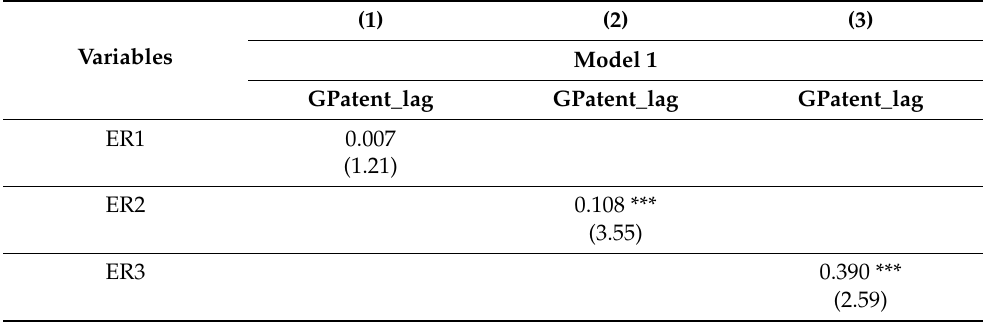
Table 5. Empirical